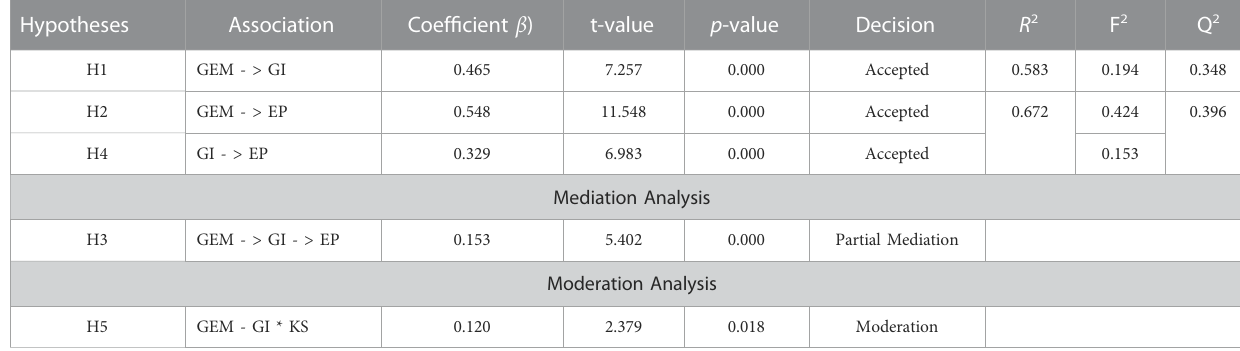
TABLE 3 Hypothesis testing.